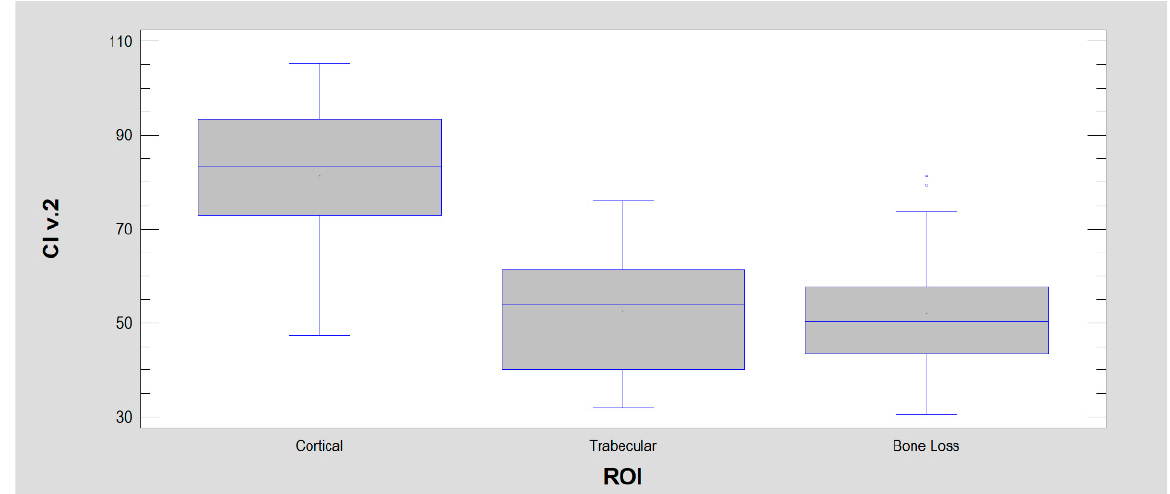
Figure 5. Corticalization index ver. 1 (CI v. 1) is based on two components included in BI and mean optical density. The components are arranged inversely to the BI to emphasize the corticalization sites rather than trabeculation, and the mean optical density enhances this effect because it is located in the numerator and is highest in the cortical bone.